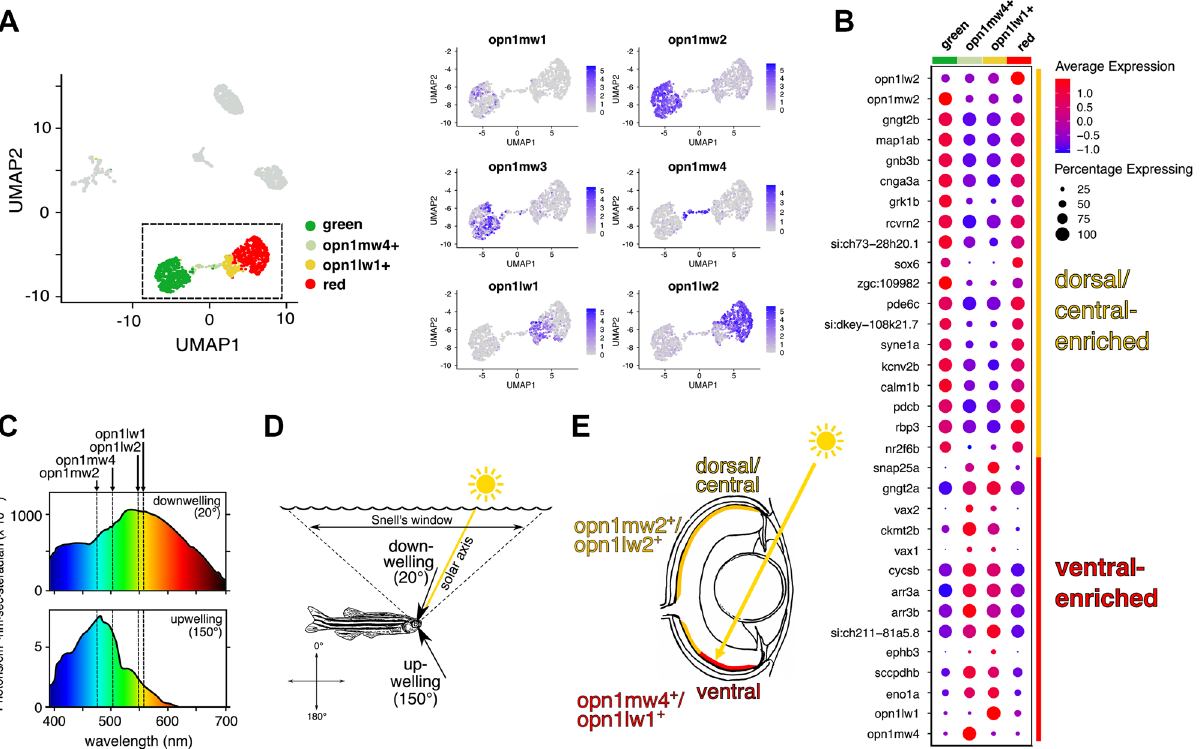
Figure 2. A distinctive subpopulation of red and green cones in the ventral retina. ( A ) Left: UMAP plot of cell clusters from Fig. 1C. Cell clusters except for green and red cones are colored gray. The opn1mw4 + / opn1lw1 + cells were split into two sub-clusters ( opn1mw4 + and opn1lw1 + ) based on the expression of opn1mw4 + and opn1lw1 + . Right: Expression of green and red cone opsin genes within the cell populations enclosed by the dotted box in the UMAP plot. ( B ) Expression of the top 30 most differentially enriched genes (ranked by adjusted p-value) between ventral ( opn1mw4 + and opn1lw1 + ) and dorsal/central ( opn1mw1/2/3 + and opn1lw2 + ) green and red cones. Green and red cone clusters were identical to those in ( A ). Dot size reflects the percentage of cells within the cluster expressing the gene, and dot color indicates average expression level within the cluster. ( C – E ) Ventrally localized opn1mw4 + and opn1lw1 + cones are positioned to detect downwelling light. ( C ) Intensity/spectral distributions for two lines of sight (downwelling light and upwelling light, 20° and 150° from vertical, respectively). These spectra were measured at a depth of 3 m in the lagoon of Enewetok (formerly Eniwetok) Atoll in the Marshall Islands. Data are reproduced from a previous study 62 . The maximum sensitivity of green and red opsin genes are indicated as dotted lines overlying the intensity/spectral distributions 16 . ( D